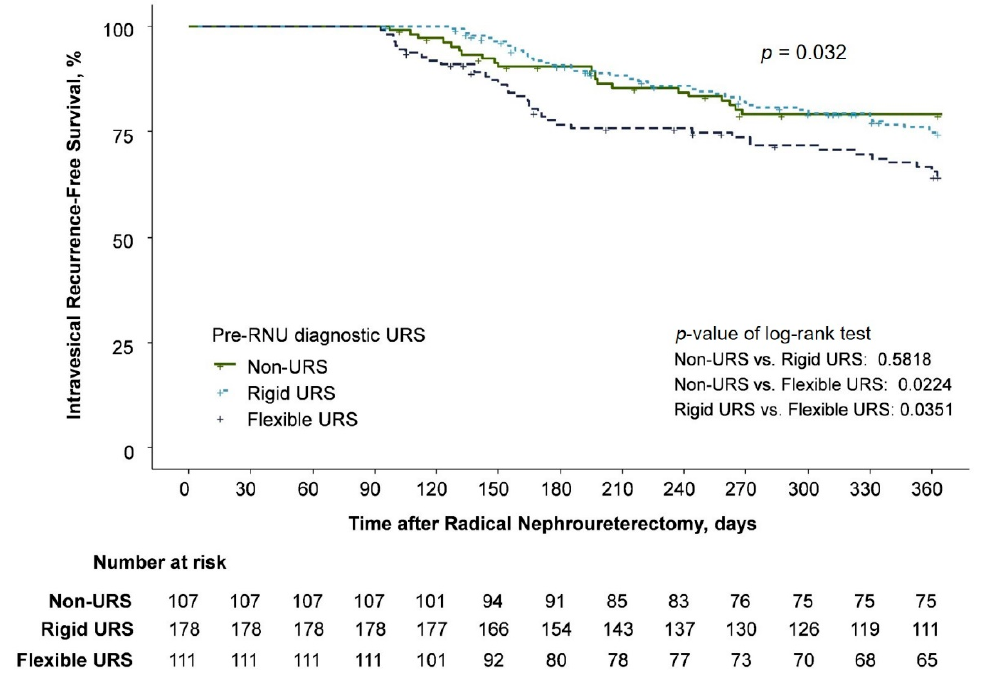
Figure 1. Kaplan–Meier estimates for intravesical recurrence-free survival. Table 3. Univariable and multivariable Cox regression analysis.